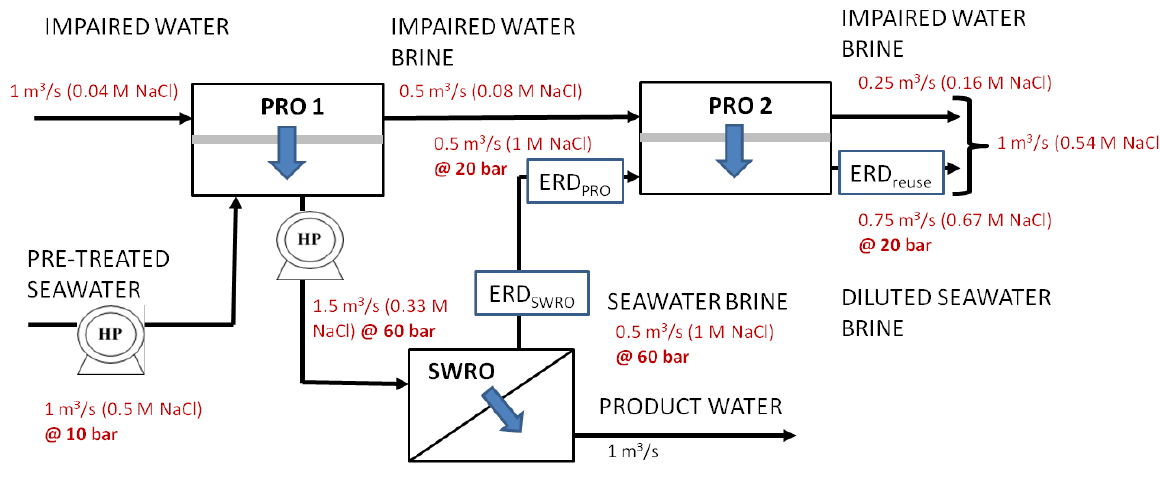
Figure 6. Configuration pressure retarded osmosis (PRO) 1, diluted seawater water feed using impaired water (water reuse brine) with dual-stage recovery of osmotic energy.